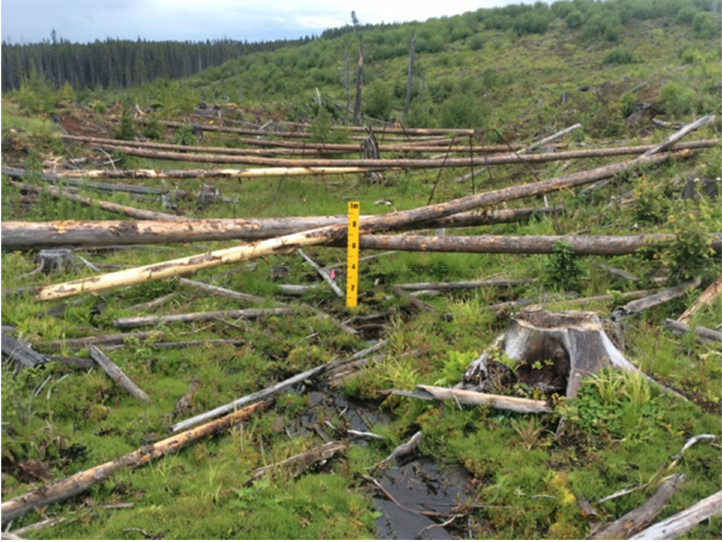
Figure 8. Cross-sectional view of log obstruction across riparian area. (Photo by C. Bradley).